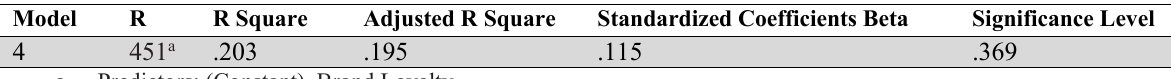
Model Summary for the fourth